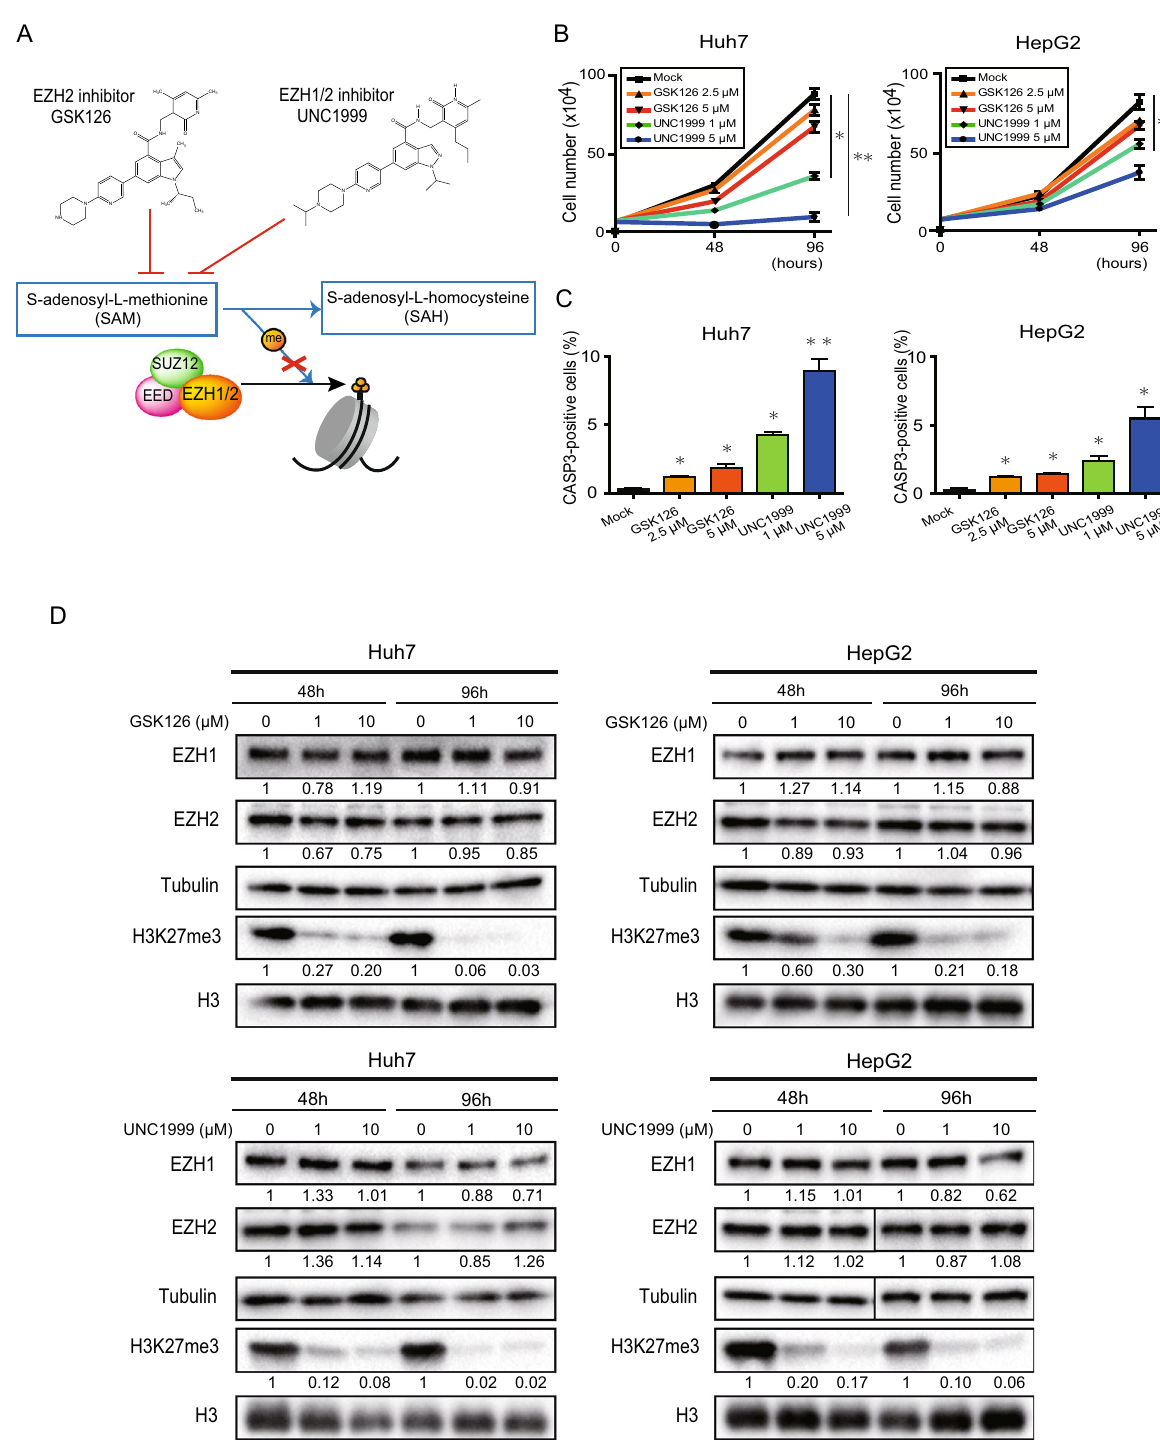
Figure 3. In vitro assays of Huh7 and HepG2 cells treated with GSK126 or UNC1999. ( A ) GSK126 and UNC1999 inhibit S-Adenosyl methionine competitively. ( B ) Cell growth inhibition of HCC cells treated with GSK126 and UNC1999 (repeated measures ANOVA, * p < 0.05, ** p < 0.01). ( C ) Quantification of apoptotic cells treated with GSK126 and UNC1999 for 48 h based on percentages of CASP3-positive cells by immunostaining (Student’s t test, * p < 0.05, ** p < 0.01). ( D ) Western blot analysis for EZH1, EZH2 and H3K27me3 after treatment of HCC cells with a range of concentrations of GSK126 and UNC1999 for 48 or 96 h. RI was shown as the means of three independent